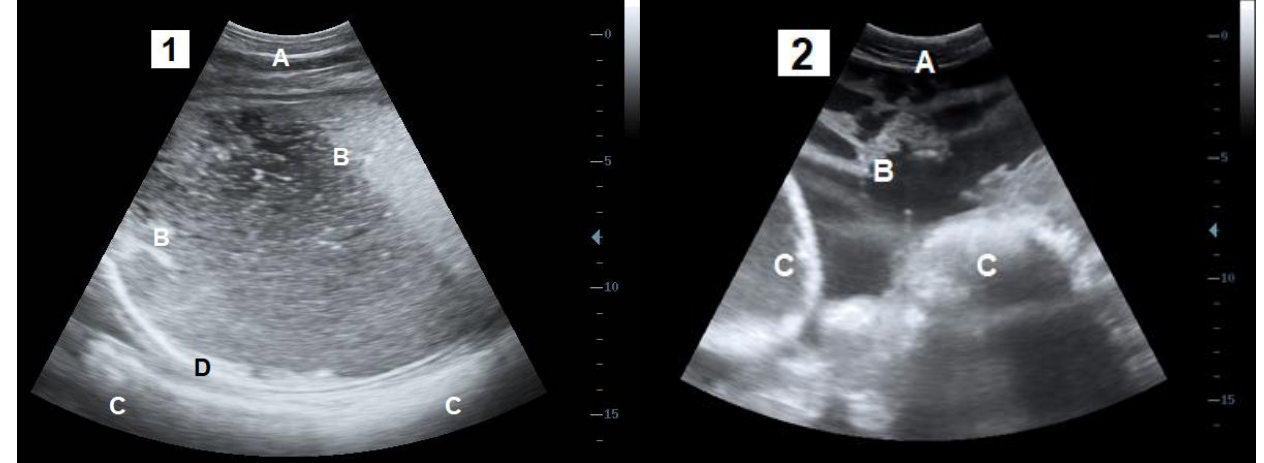
Figure 1. Transabdominal ultrasound sections of the parietal fibrinous peritonitis ( 1 ) and generalised peritonitis ( 2 ). A: Abdominal wall; B: Lamellas of fibrin and inflammatory fluids; C: Digestive organs; D: fibrinous capsule.